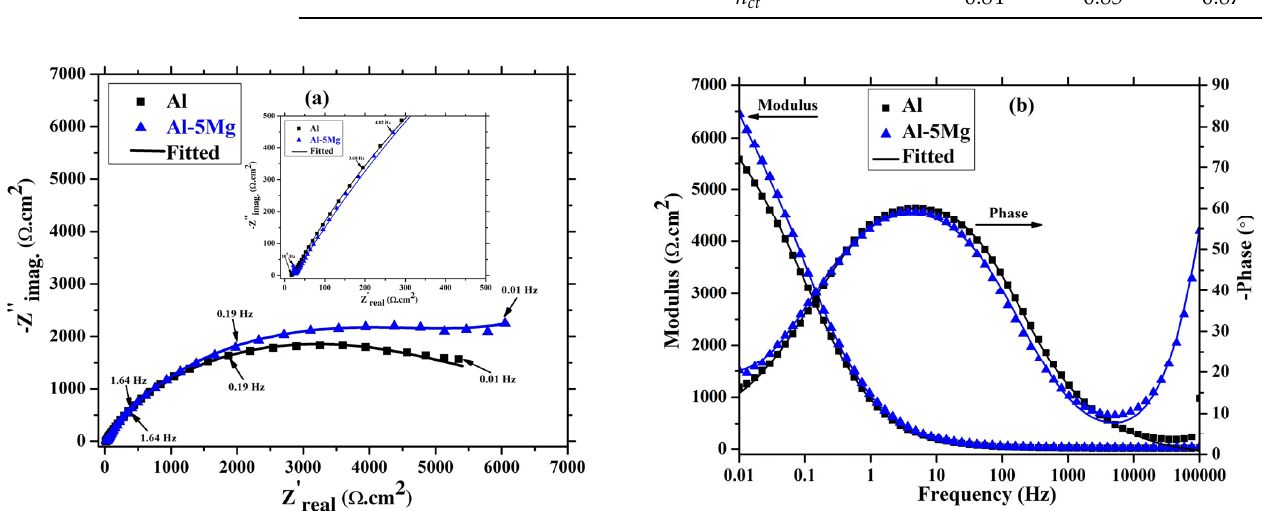
Figure 9. EIS ( a ) Nyquist and ( b ) Bode plots of coatings after 41 d of immersion in 3.5 wt.% NaCl solution.